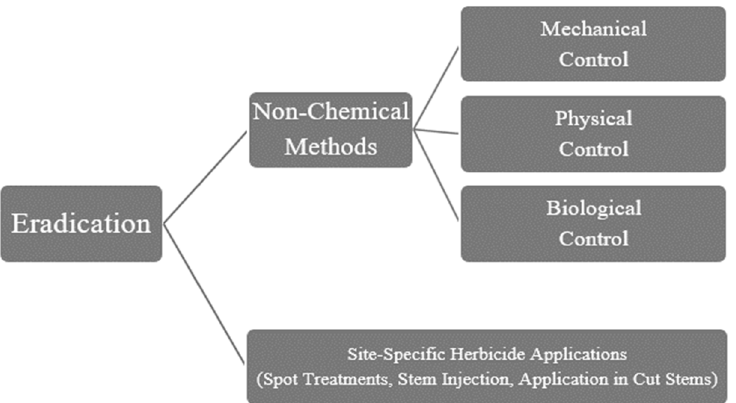
Figure 2. Weed control practices that should be combined to eradicate populations of the selected invasive perennial herbaceous alien plant species included in the current study.